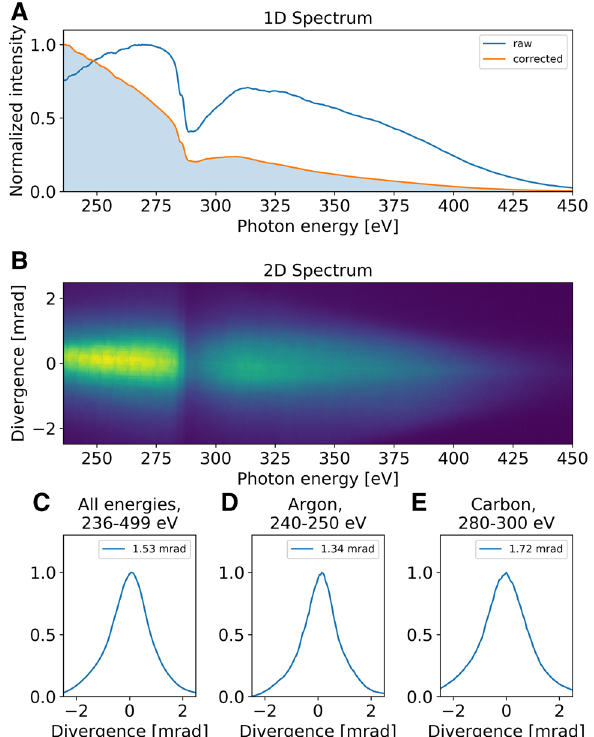
Figure 4. Spatially-resolved harmonic spectrum generated in helium. ( A ) Typical HHG spectrum with the photon flux optimized for measurements at the carbon K-edge. The blue curve is the raw data, the orange one has been corrected by the Jacobi factor and 150-nm-thick Al filter transmission. ( B ) 2D corrected-HHG spectrum, showing both the photon energy (horizontal axis) and divergence (vertical axis). Beam divergence profiles integrated over all energies detected by the CCD-camera chip ( C ); over 240–250 eV energy range at the argon L-edge ( D ); over 280–300 eV energy range at the carbon K-edge ( E